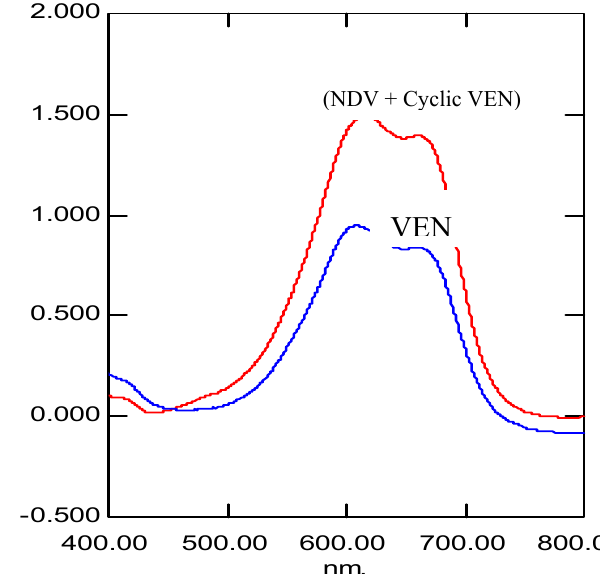
Figure 3. UV–Vis spectra showing absorption maxima of colored complex of VEN (608.5 nm) and colored complex of NDV + Cyclic VEN (616.5 nm).